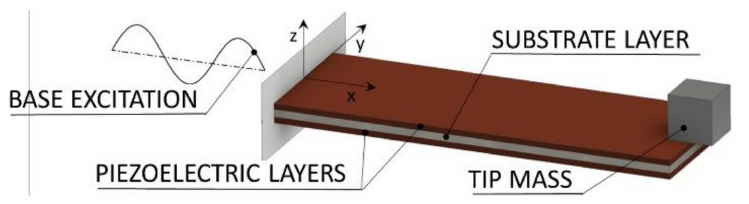
Figure 2. Bimorph piezoelectric energy harvester